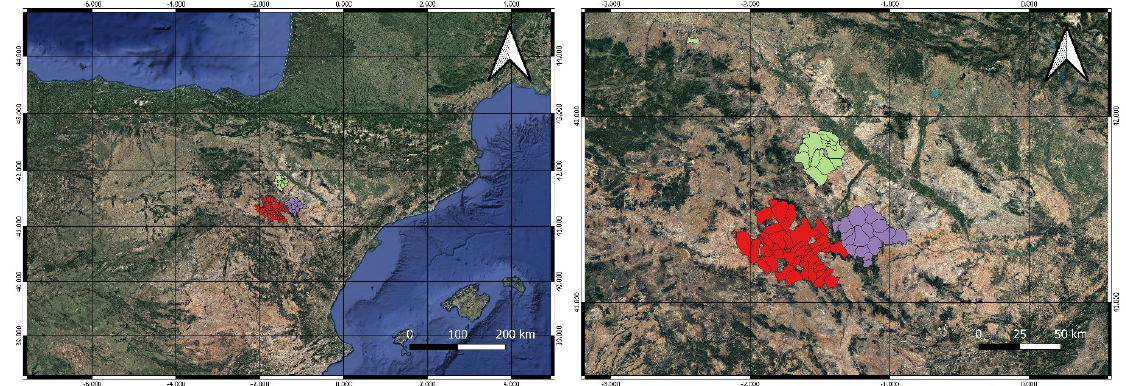
Figure 3. Map of the study area with the three protected designations of origin (Cariñena, in violet color; Campo de Borja, in green color; and Calatayud, in red color), in the province of Zaragoza, region of Aragón, Northeastern Spain. Map generated with QGIS [64] . Source: Government of Aragón-Geographical Institute of Aragón (https://idearagon.aragon.es/portal/, accessed 21 December 2022).